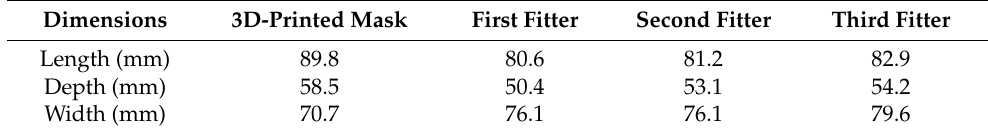
Table 5. Mask dimensions before and after molding to various fitters [30]. Dimensions